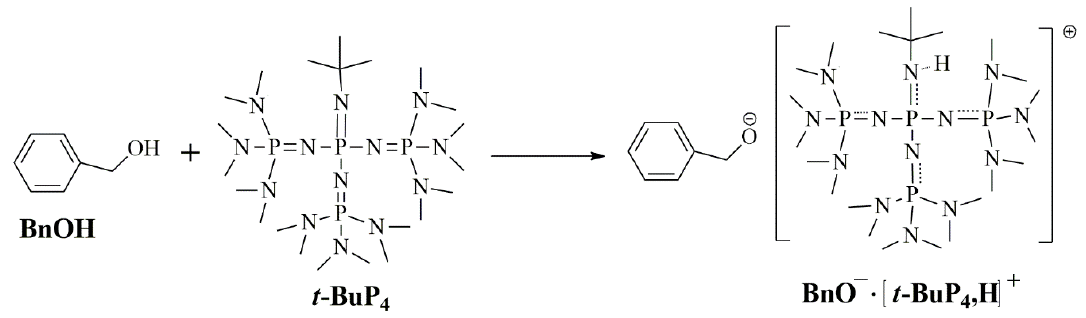
Figure 6 . 1 H NMR spectra of ( A ) BnOH, t- BuP 4 and their 1:1 complex in C 6 D 6 , ( B ) BnOH, DBU and their 1:1 complex in C 6 D 6 .